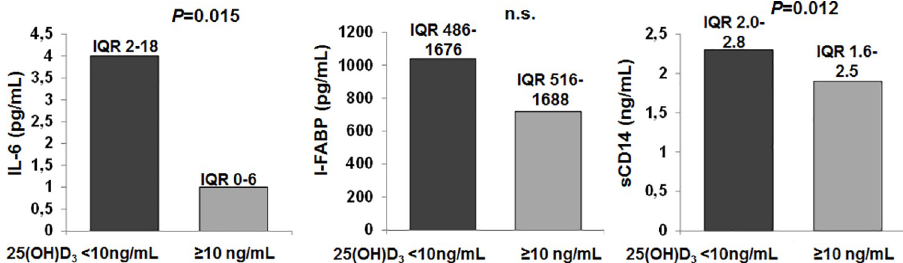
Fig 2. Baseline serum concentrations of IL-6, IFABP, and soluble CD14 accoding to the presence / absence of severe vitamin D deficiency. IQR, interquartile range.